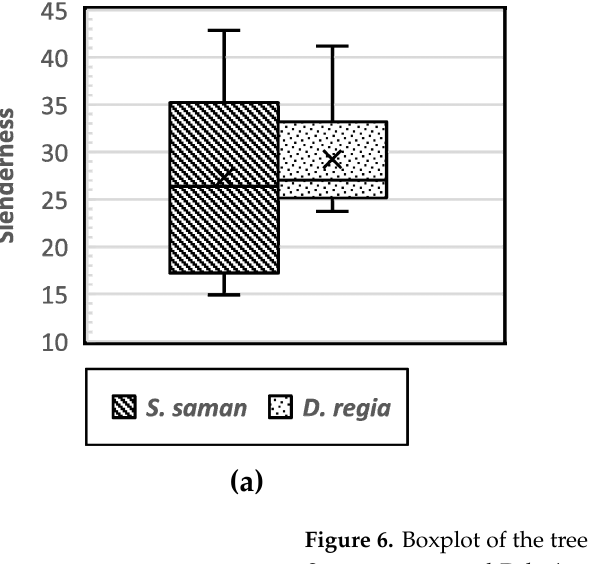
Figure 7 . The sonic velocity (m ∙ s − 1 ) detected by the Root Detector for Samanea Saman and Delonix regia .